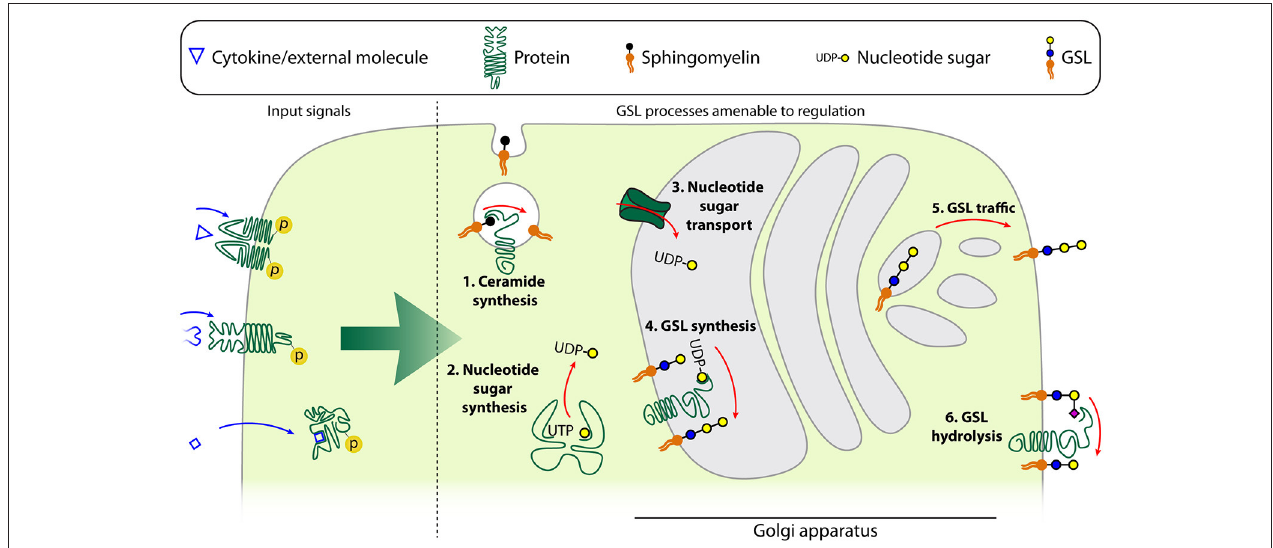
FIGURE 3 | Schematic model of the different levels of GSL regulation. Input signals described to be able to affect the GSL repertoire of a cell are either cytokines, other ligands with membrane-bound receptors or ligands with intracellular receptors. These affect the GSL repertoire by changing the expression or activity of ceramide synthases such as acidic sphingomyelinase (1), nucleotide sugar synthases in the cytoplasm (2), nucleotide sugar transporters which transport the nucleotide sugars into the Golgi apparatus (3), glycosyltransferases (4), trafficking of the GSLs from the Golgi apparatus to the plasma membrane (5), or glycosidases